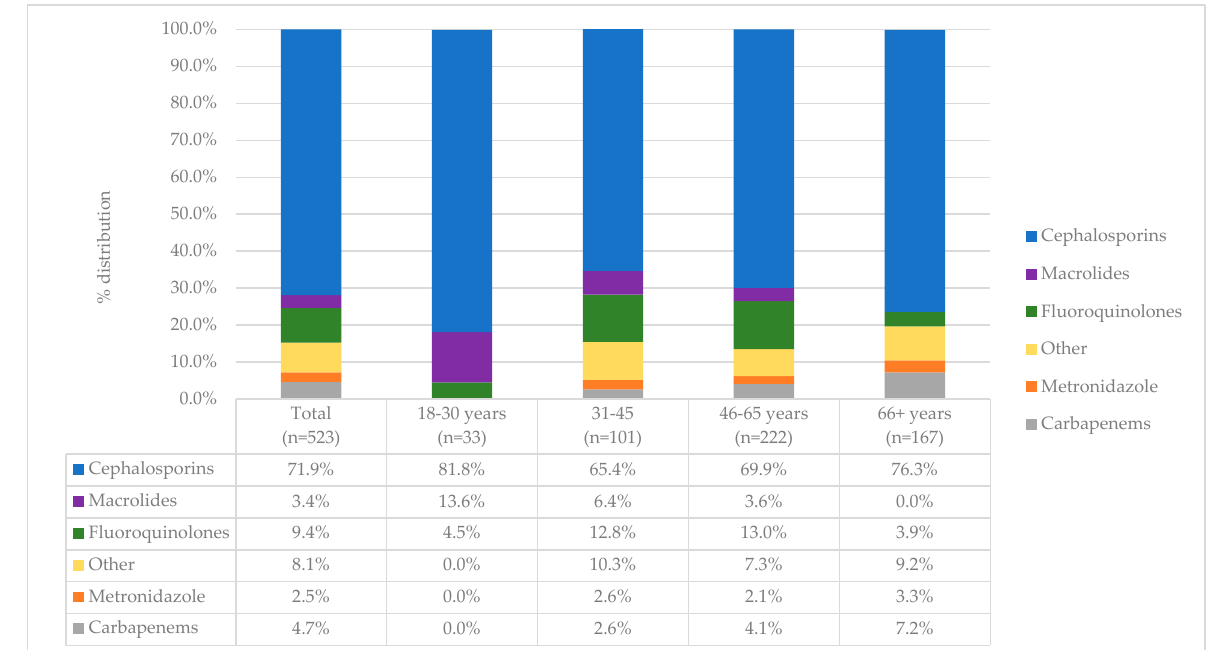
Figure 4. Post-admission profile of antibiotics used across major age groups .